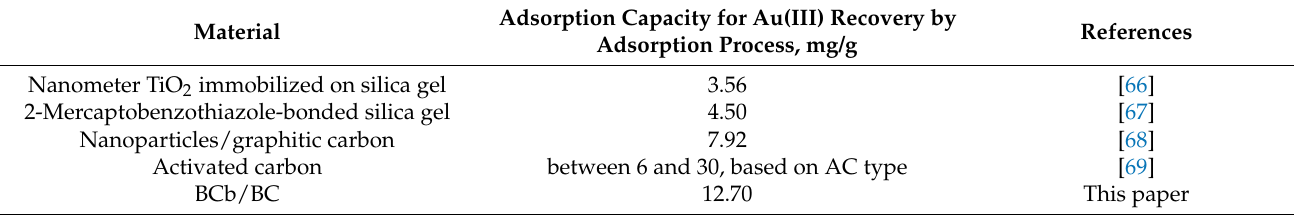
Table 6. Comparisons with other materials with adsorbent properties in order to recover Au(III) from aqueous